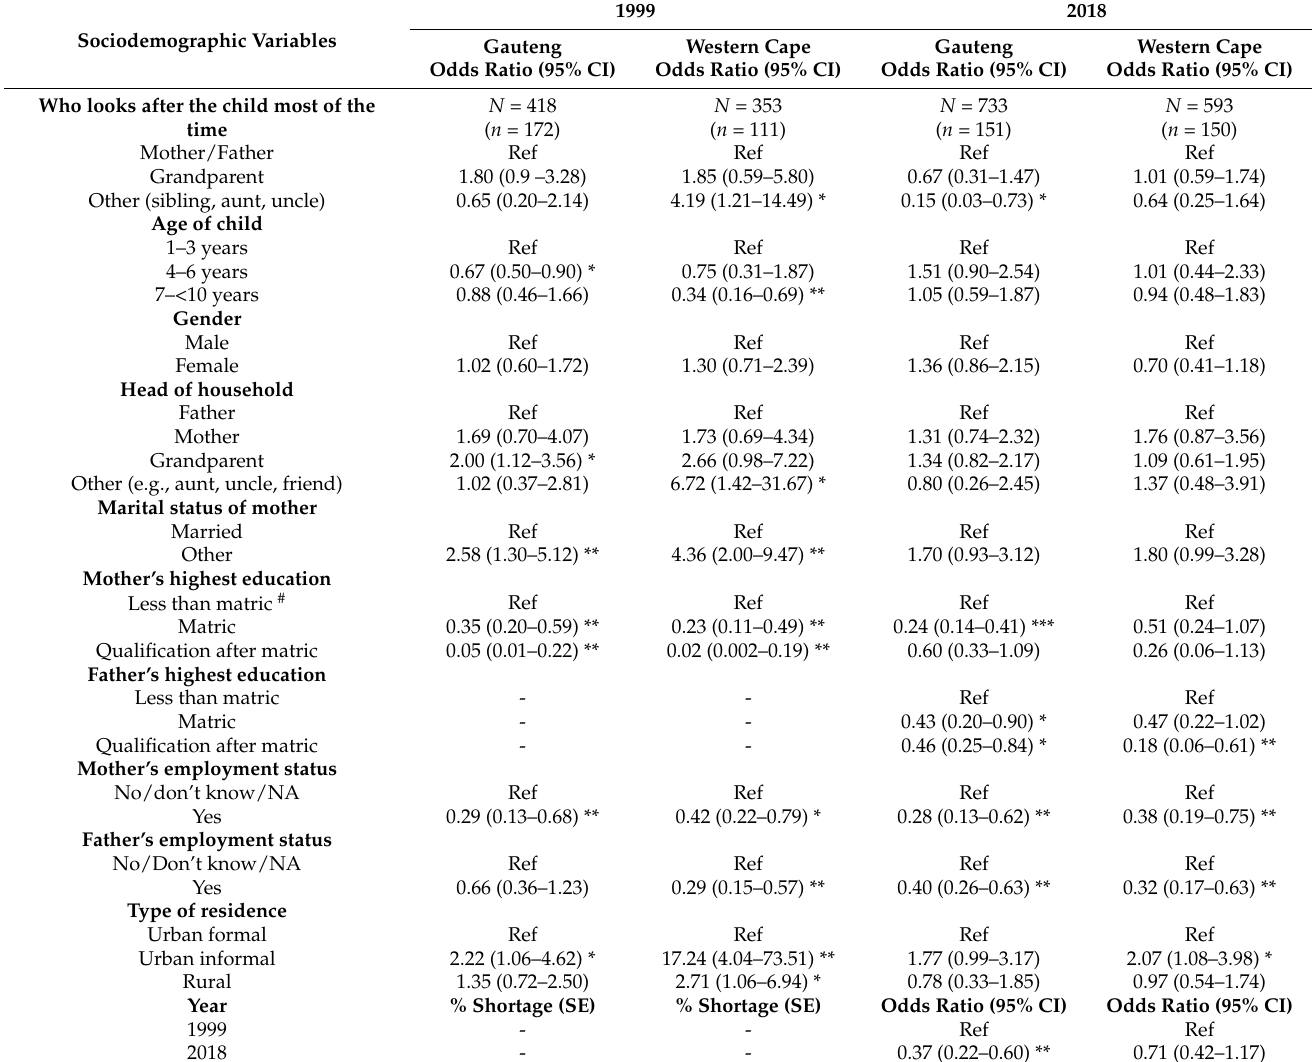
Table 9. Bivariate logistic regression to identify socio-demographic predictors of food shortage